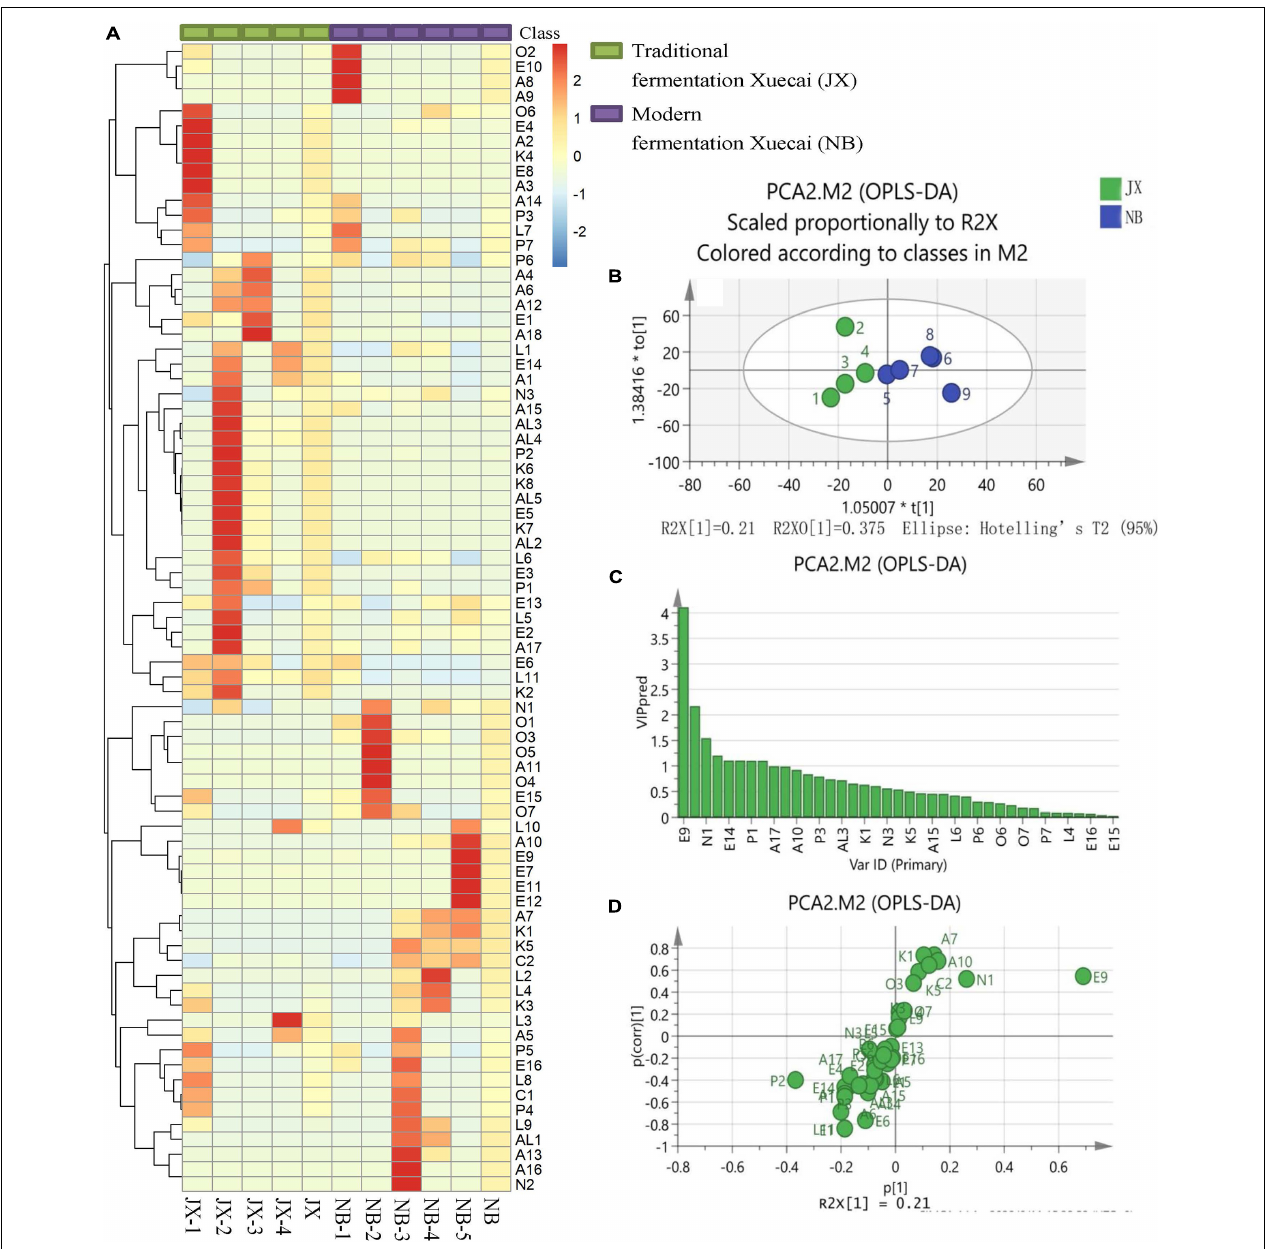
FIGURE 1 | Heatmap visualization (A) , OPLS-DA score plot (B) , VIP plot (C) , and loading S-plots (D) of the flavor compounds in traditional fermentation Xuecai and modern fermentation Xuecai based on GCMS data. For interpretation of the code in this figure, the reader is referred to the Table 2 and Supplementary Table 2